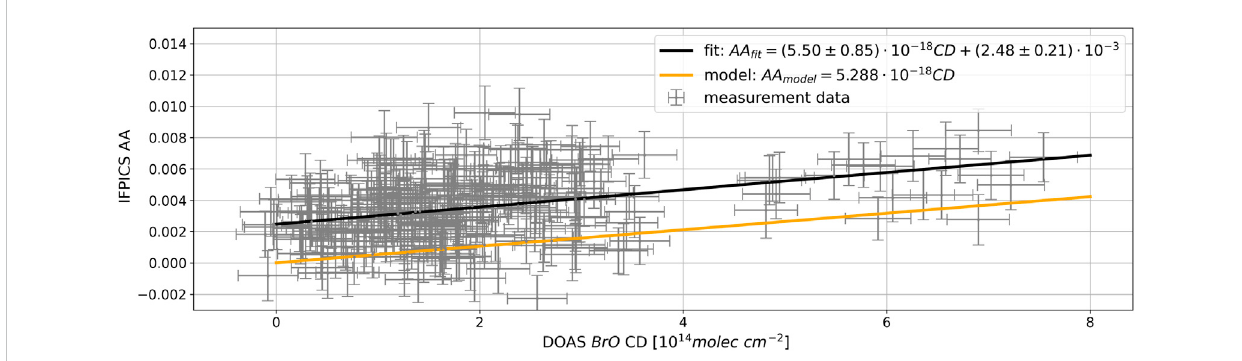
FIGURE 9 CalibrationcurveoftheBrOmeasurementonthe24thofJuly2021between07:38and08:24UTC.TheIFPICSAAinsidetheFOVofthenarrowFOV DOAS is plotted against the BrO CD density obtained from the DOAS measurement. A linear fi t (solid black line) gives the calibration curve of the BrO camera. The solid orange line shows the IFPICS model prediction.